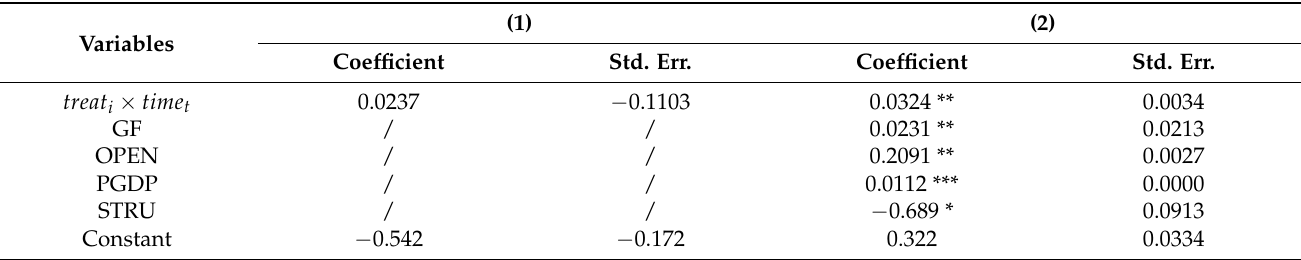
Table 6. Sorting out panel regression